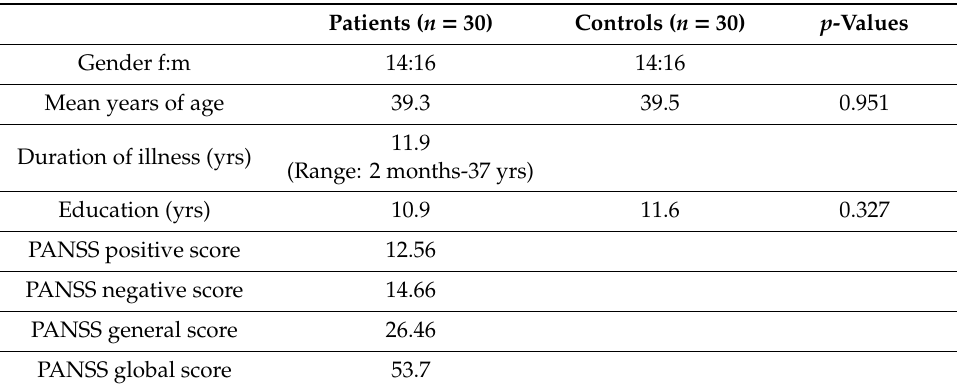
Table 1. Sociodemographic characteristics of schizophrenia patients and controls, showing no significant di ff erence in age and education between the two